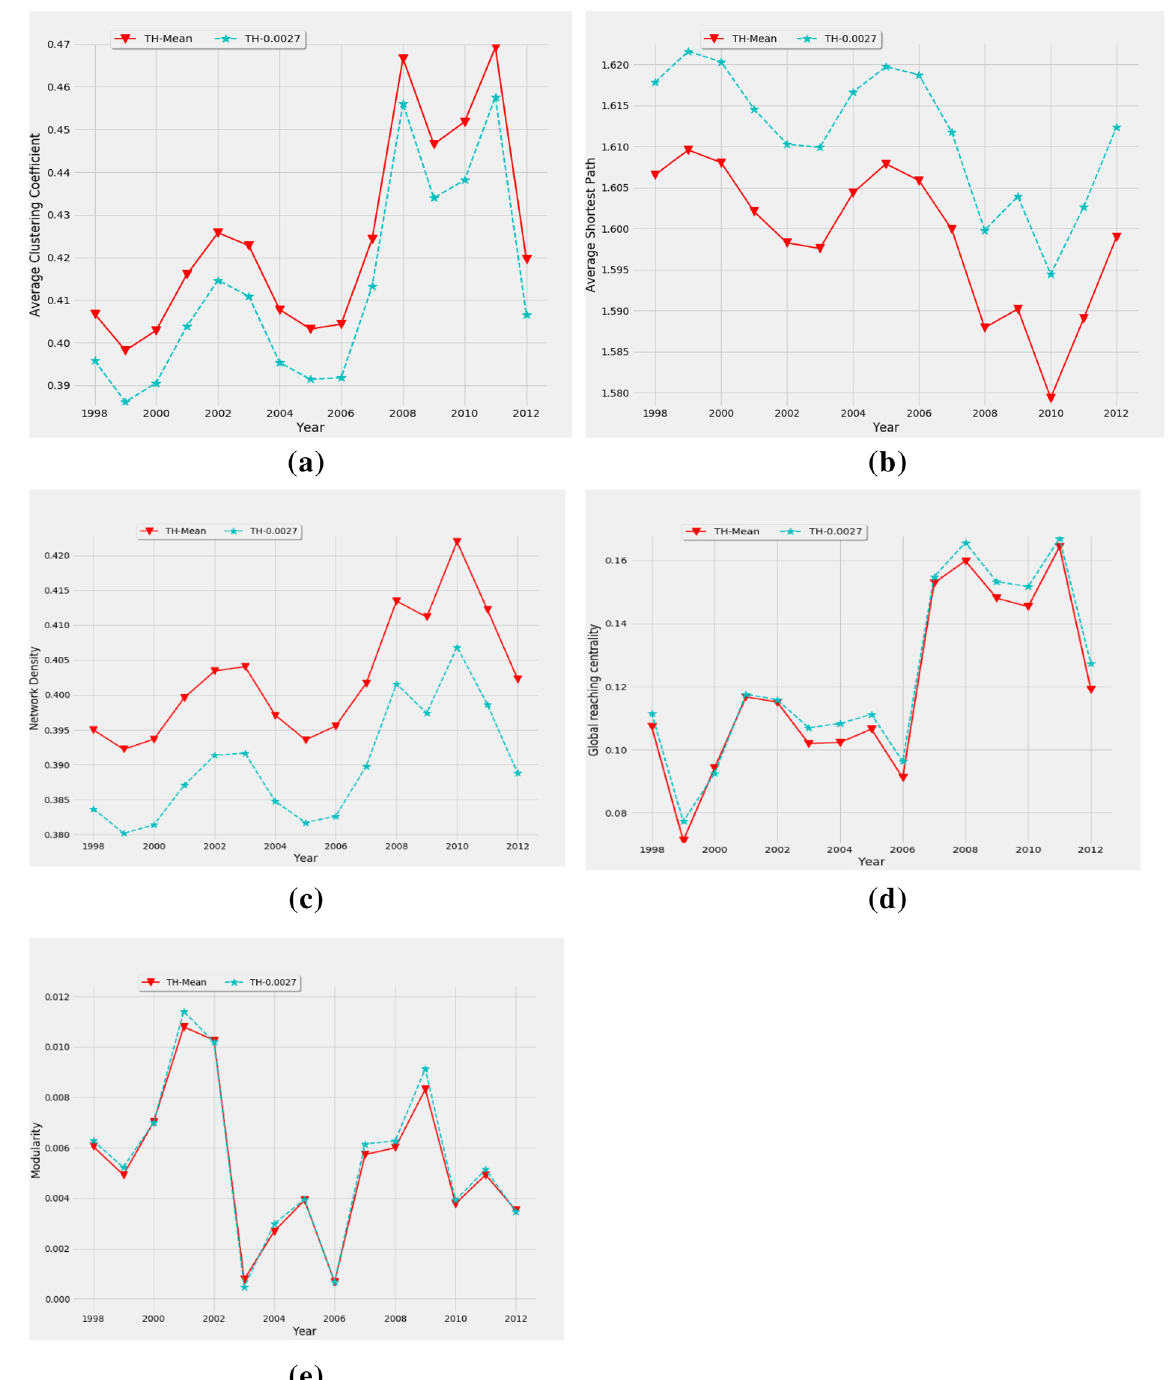
Figure 4. Network properties of the static threshold network for s&p500: ( a ) average clustering coefficient, ( b ) average shortest path length, ( c ) network density, ( d ) global reaching centrality, and ( e )